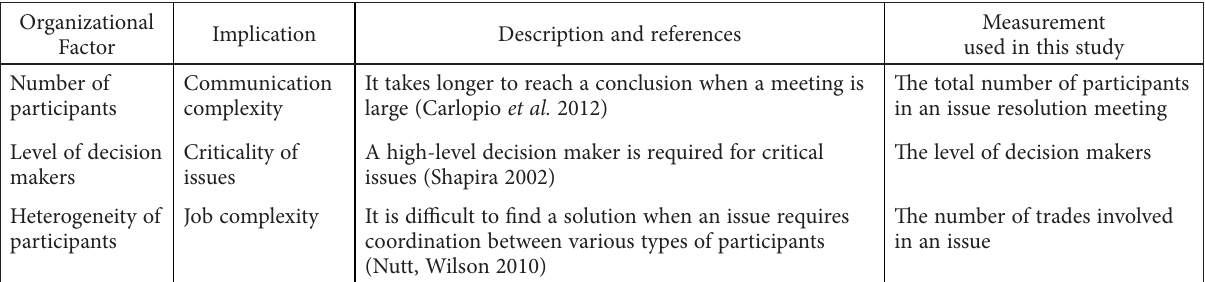
Table 2. Major organizational factors affecting decision-making